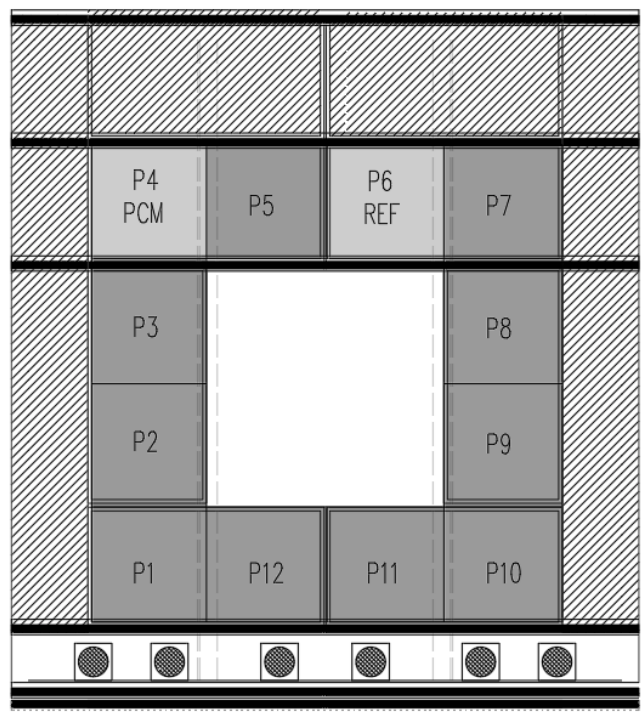
Figure 2. Front view of the facade with internal division into 12 sections. REF: Reference .